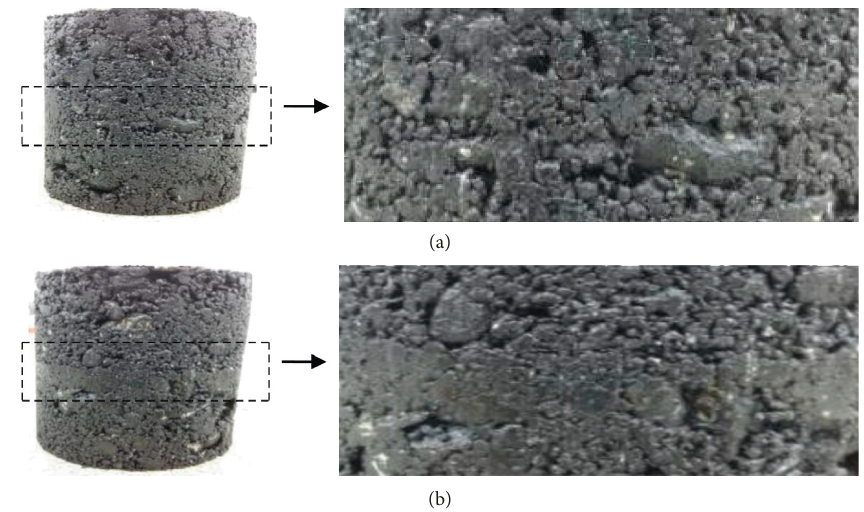
Figure 3: Discontinuous and continuous Marshall specimens. (a) Continuous paving. (b) Discontinuous paving.